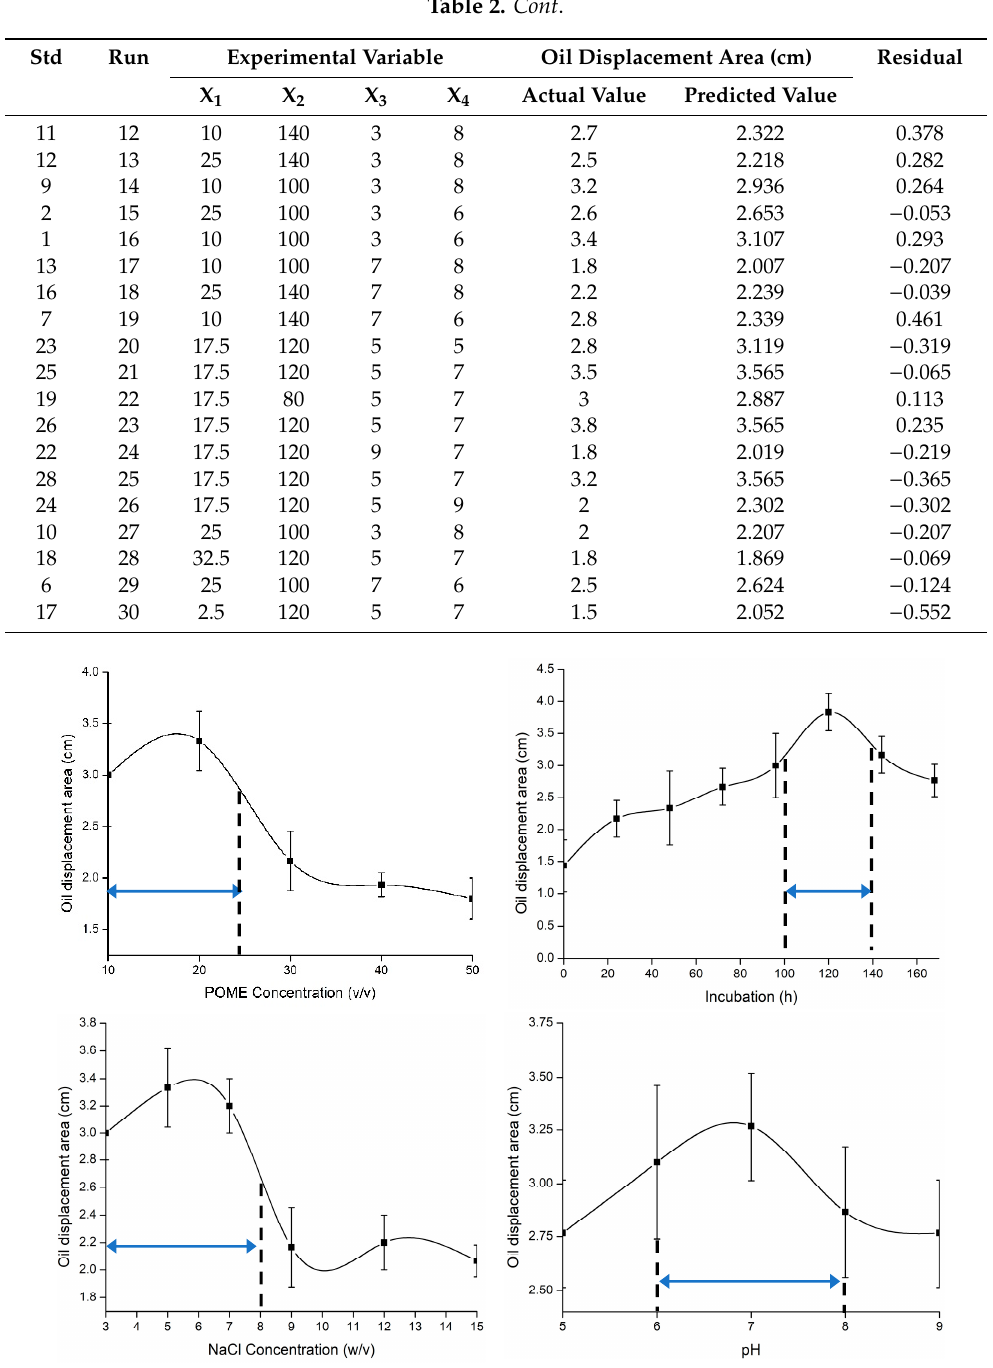
Figure 2. The range of optimization area (arrow) to the factors that influence the biosurfactant production.